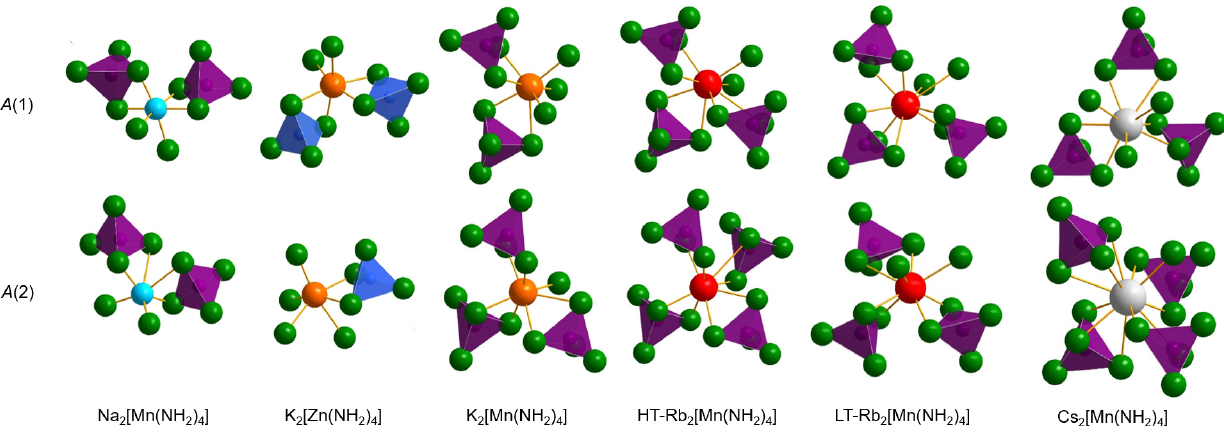
Figure 4. Different coordination environments of alkali metal sites in A 2 [Mn(NH 2 ) 4 ] ( A = Na – Cs) and K 2 [Zn(NH 2 ) 4 ] [7,17–19], the A (1) site is shown in the top row, A (2) below. Manganese is pictured in purple, zinc in dark blue and nitrogen in green. [ M (NH 2 ) 4 ] 2– tetrahedra only coordinating via one amide group are omitted for